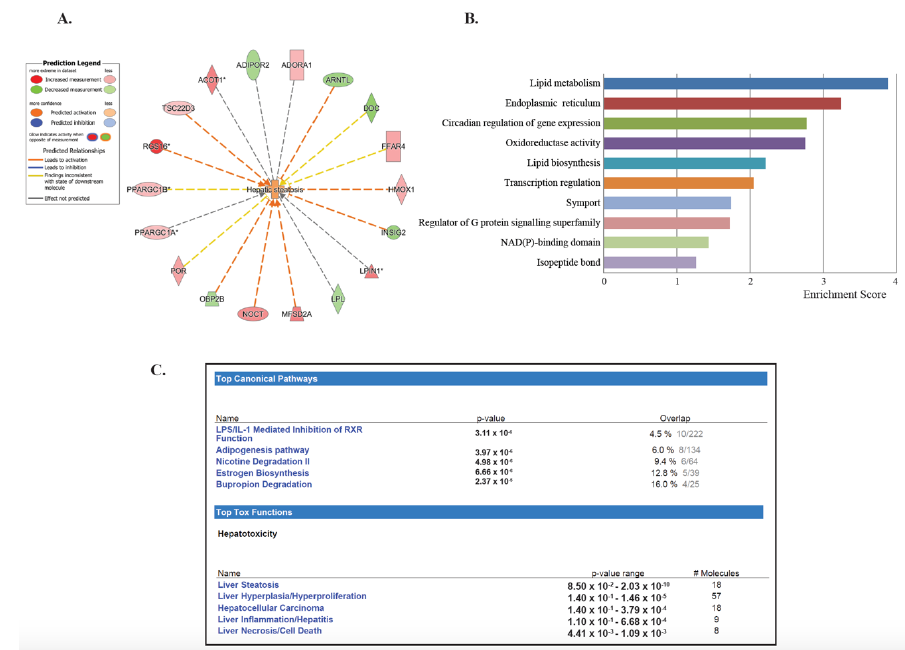
Figure 2. Gene-set enrichment analysis of deregulated genes in SHS-exposed mice. We performed gene ontology analysis on the 153 unique genes identified in SHS-exposed mice, before and after recovery, relative to controls. ( A ) Eighteen genes are specifically implicated in hepatic steatosis. Red and green nodes represent up-regulated and down-regulated genes, respectively. ( B ) The Functional Clustering Analysis tool in DAVID was used to group together redundant annotations. The top ten categories identified by DAVID, with a group enrichment score between 1.26 and 3.88 ( x -axis), are listed on the y -axis. ( C ) The top canonical pathways and hepatotoxic functions were displayed along with the significance values and number of associated molecules and included, among others, liver steatosis, inflammation and necrosis.